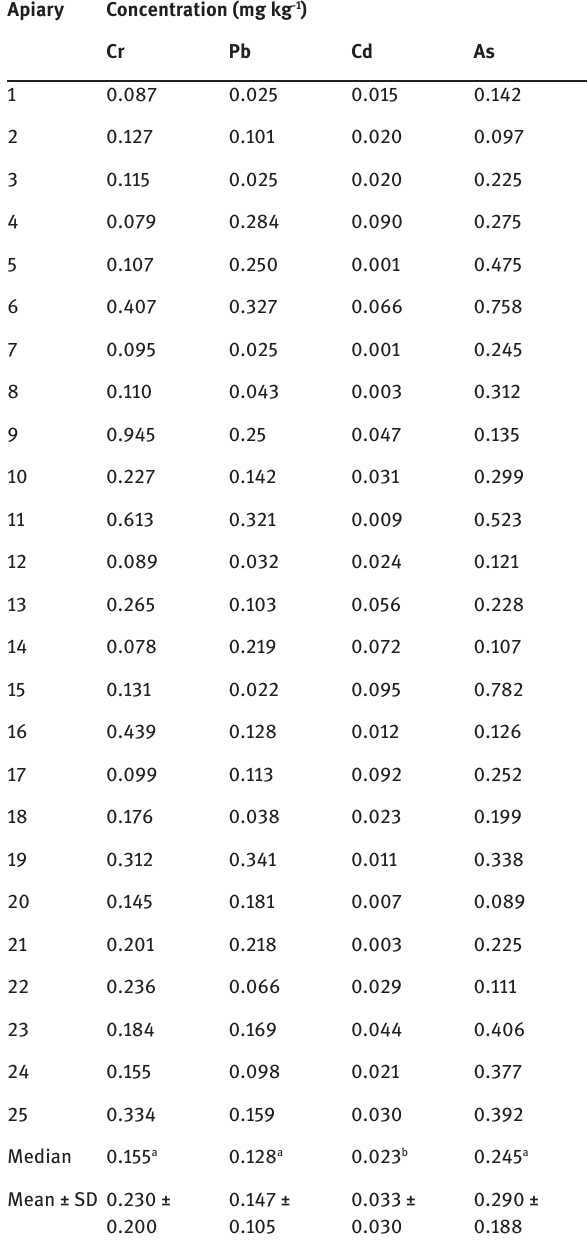
Table 1: Toxic elements in bee pollen loads from Lower